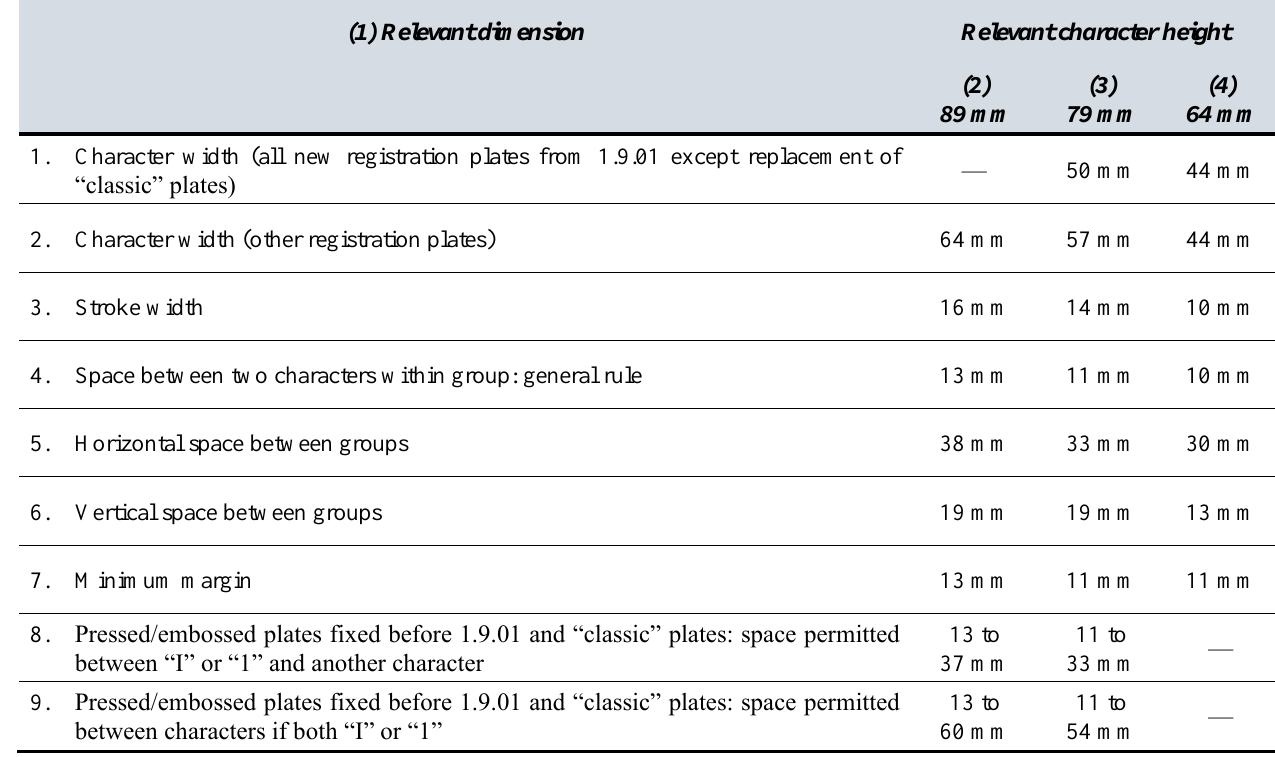
Table 1. ‘Table B: Stroke and Character Width, Spacing and Margins’ from 2001 Regulations, sch 3 part 3 (1) Relevant